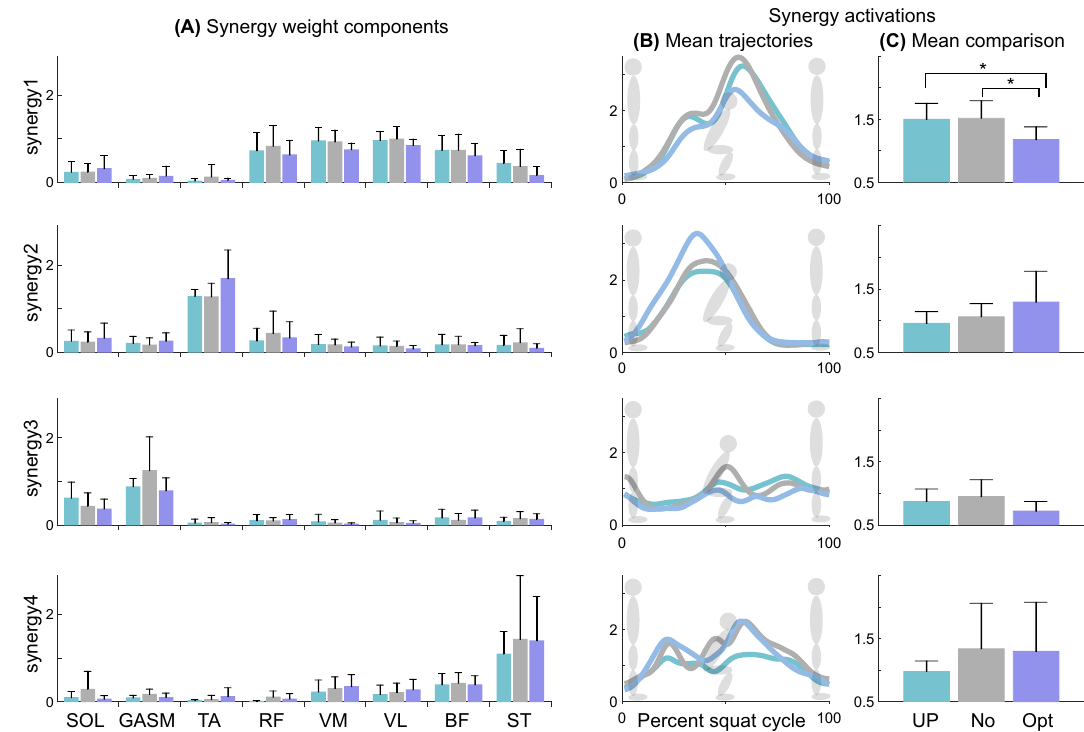
Figure 4. Comparison of 4 main synergies for three different conditions, unpowered (UP), no-device (NO), and optimal (Opt). ( A ) Synergy weight component. ( B ) Synergy activation trajectory through the squat cycle. ( C ) The mean values of synergy activations. Bar graphs show the mean and standard deviation. For statistical expression, * is p <